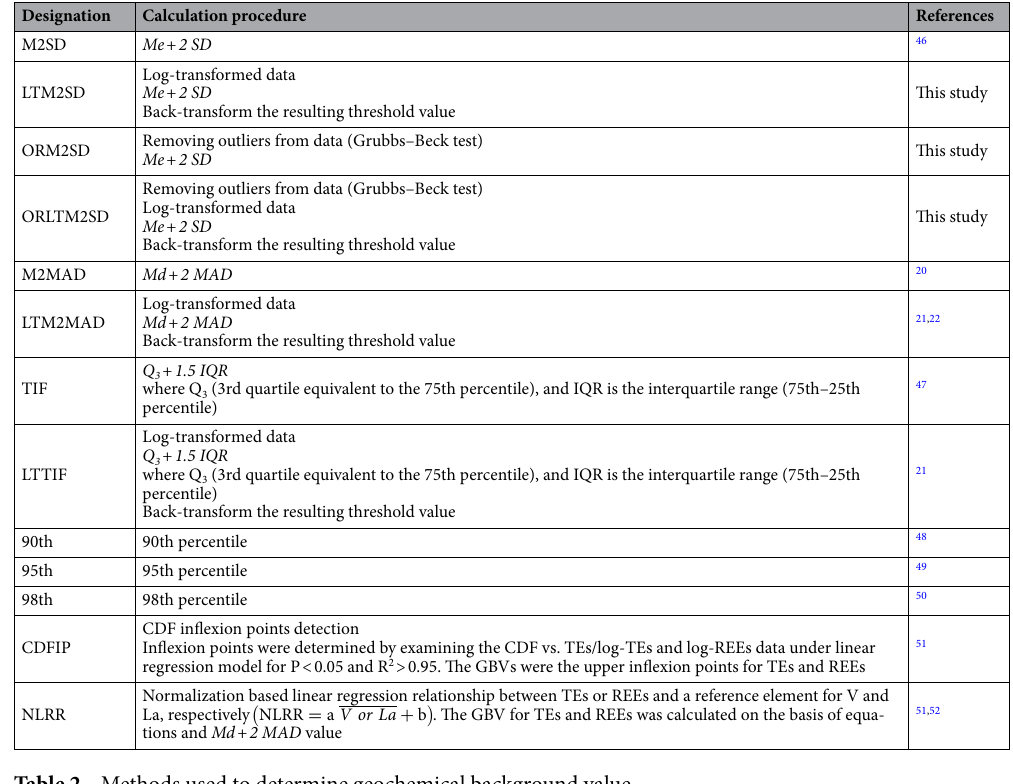
Table 2. Methods used to determine geochemical background value.